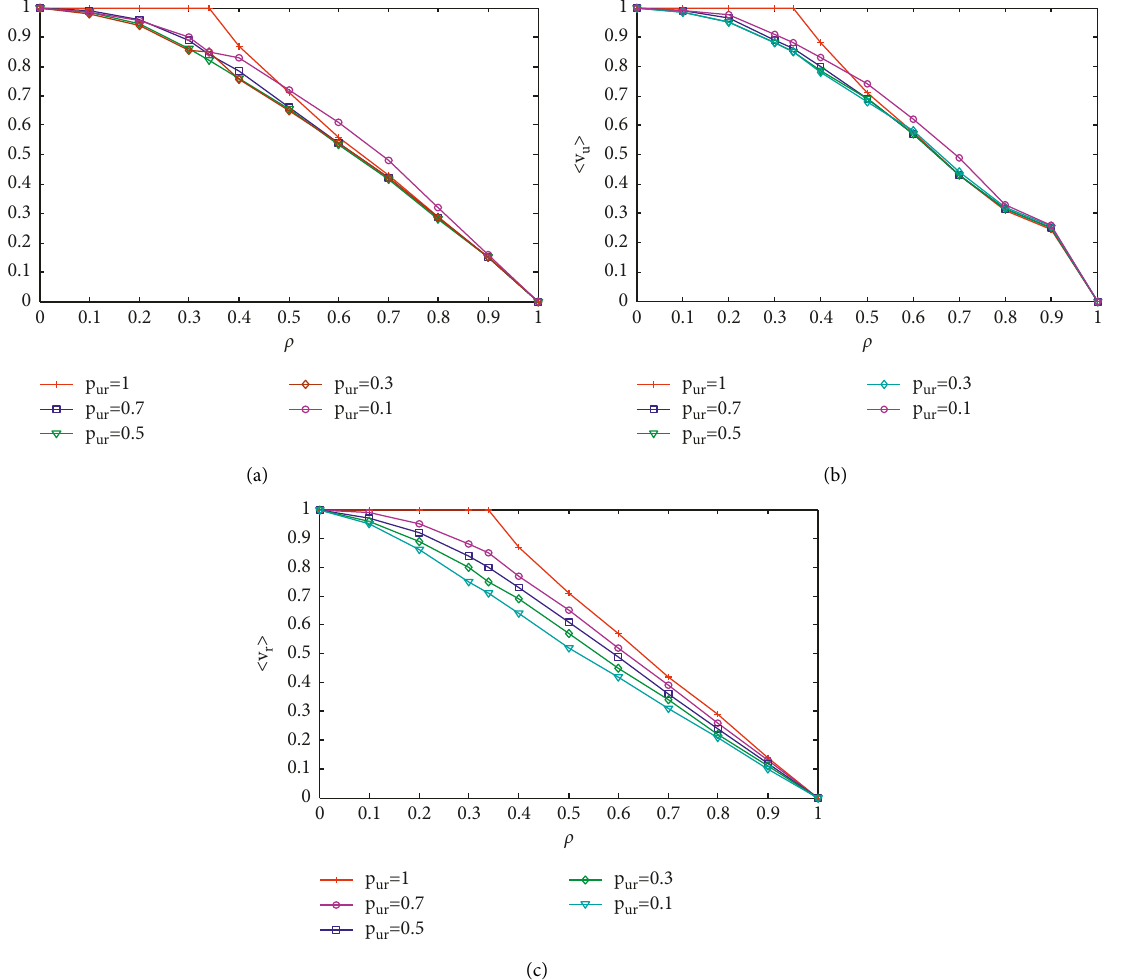
Figure 3: When p � 1 and L � 100, (a) the relationship between global average velocity and density, (b) the relationship between average velocity ru of upward vehicles and density, and (c) the relationship between average velocity of right-moving vehicles and density, with different values of p ur .